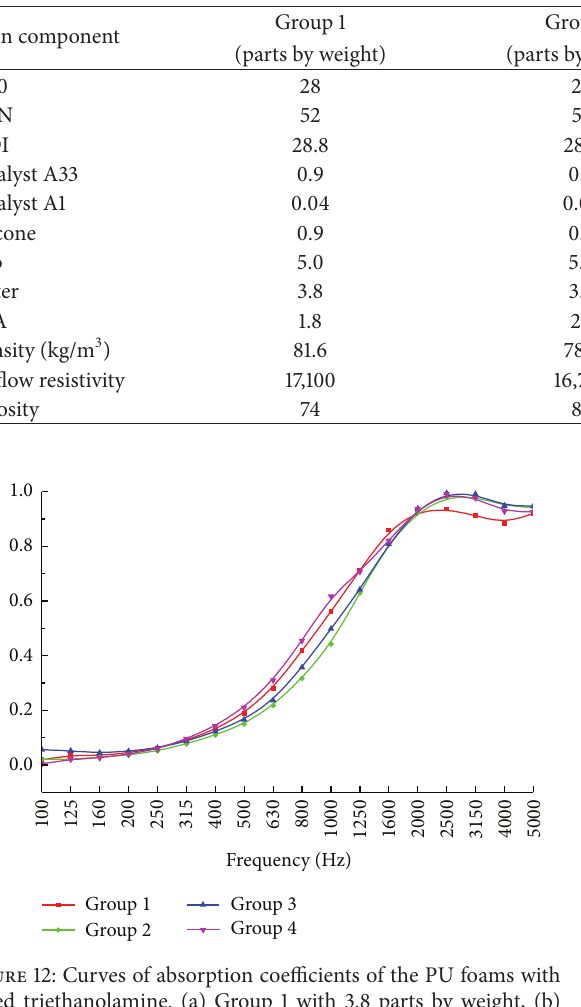
Table 5: Main components and properties of the foams.